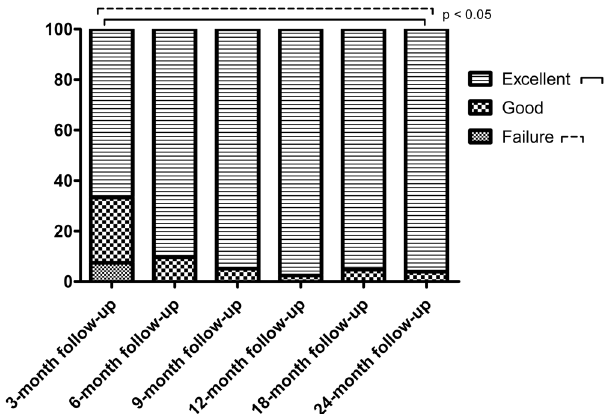
Figure 3. Result of bariatric surgery cataloguing based on postsurgery weight loss. Failure: %EBMIL < 50%; Good: %EBMIL = 50%-65%; Excellent: %EBMIL > 65%. No patients were lost to